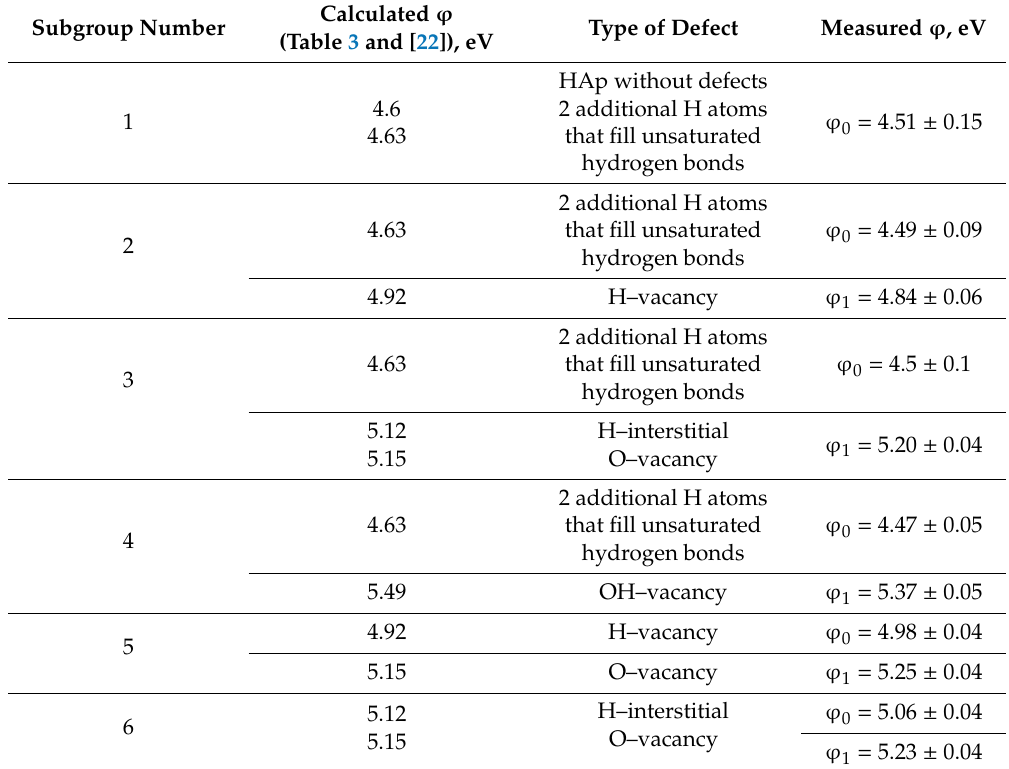
Table 7. Subgrouping of the samples of the group